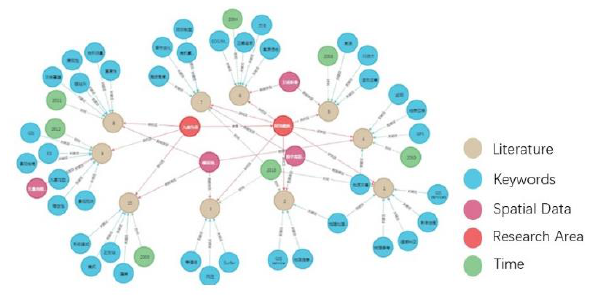
Figure 7 . Knowledge graph visualization.